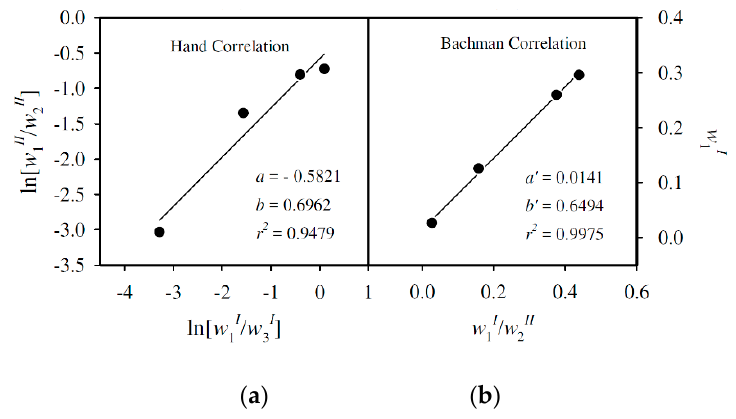
Figure 5. ( a ) Hand; and ( b ) Bachman correlation plots of the lactic acid + water + AE ternary system at T = 308.15 K and P = 0.1 MPa (atmospheric